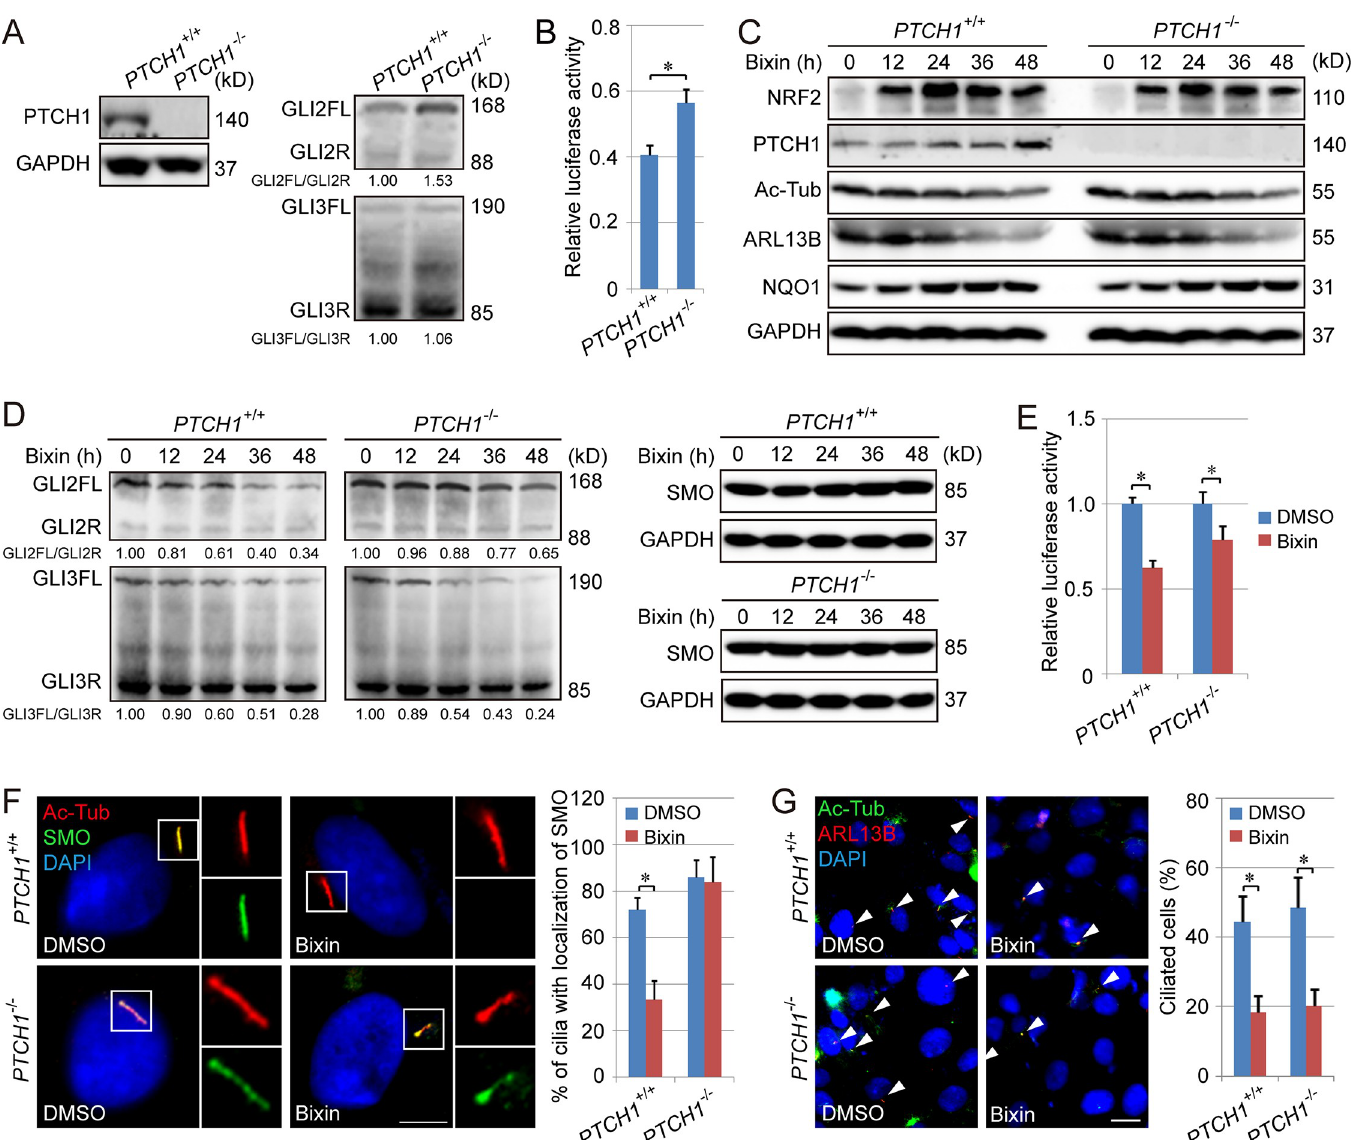
Fig 4. PTCH1 is required for NRF2-mediated inhibition of ciliary translocation of SMO but not the suppression of primary ciliogenesis by NRF2. (A) Immunoblot analysis of PTCH1, GLI2FL/R, and GLI3FL/R protein levels in a PTCH1 − / − H1299 cell line. Relative quantification of immunoblot results is shown in S7A Fig. (B) GLI μ M) for 0, 12, 24, 36, or 48 h in PTCH1 +/+ and PTCH1 − / − H1299 cells. Relative quantification of immunoblot results is shown in S7B Fig. (D) Immunoblot analysis of GLI2FL/R and GLI3FL/R, as well as SMO protein levels, following treatment with bixin (40 μ M) for 0, 12, 24, 36, or 48 h in PTCH1 +/+ and PTCH1 − / − H1299 cells.